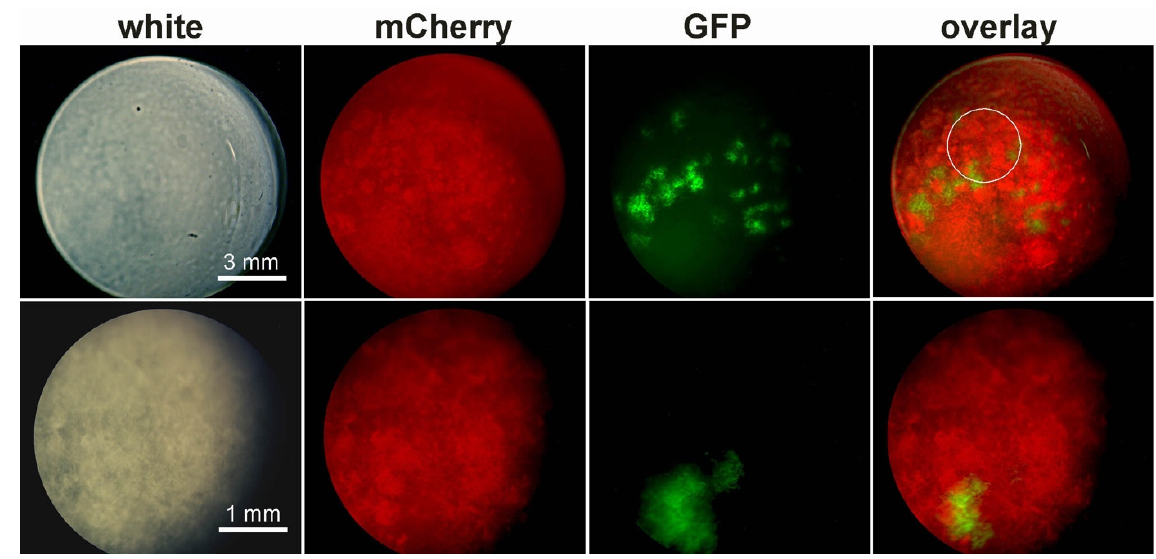
Figure 6. Recruitment of a GFP-tagged planktonic population in an mCherry-tagged biofilm. The biofilm, formed at the air–liquid interface, was observed with a fluorescence binocular microscope. Upper row, view of whole biofilm surface. Bottom row, 3-fold magnification of a region near the center of the biofilm, depicted by the white circle in the overlay of the upper row. The white bar gives the scale. White: white light; Overlay: overlay of the mCherry and the GFP channels.